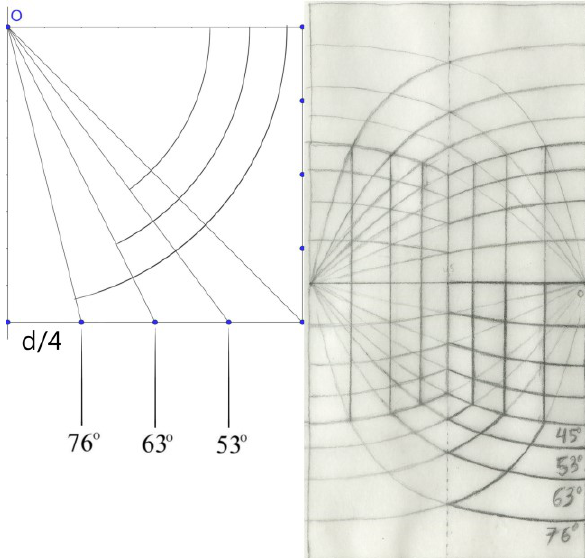
Figure 9 | Left: Protractor measurement of a uniform grid on a box. Right: Equirectangular perspective of a corner of the box. The rest can be obtained by